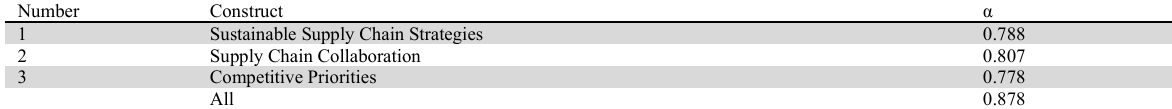
Cronbach's Alpha Coefficient for Study variables